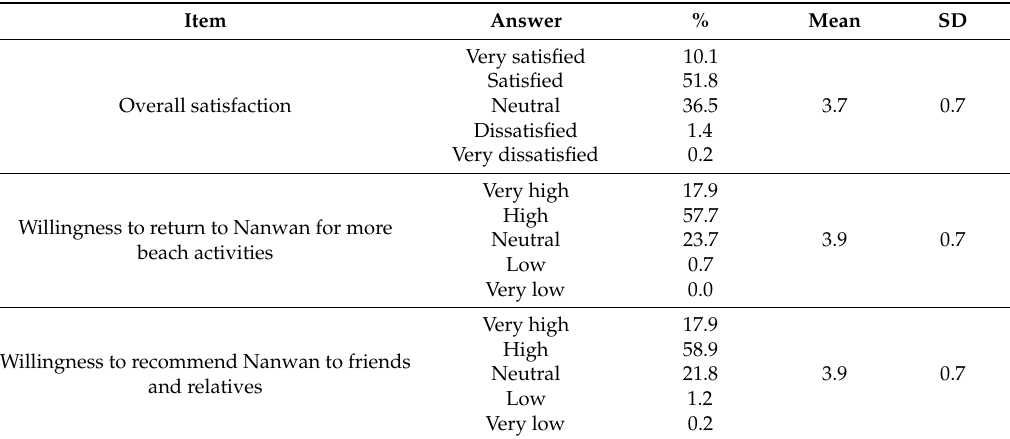
Table 3. Tourist’s level of satisfaction and intention of